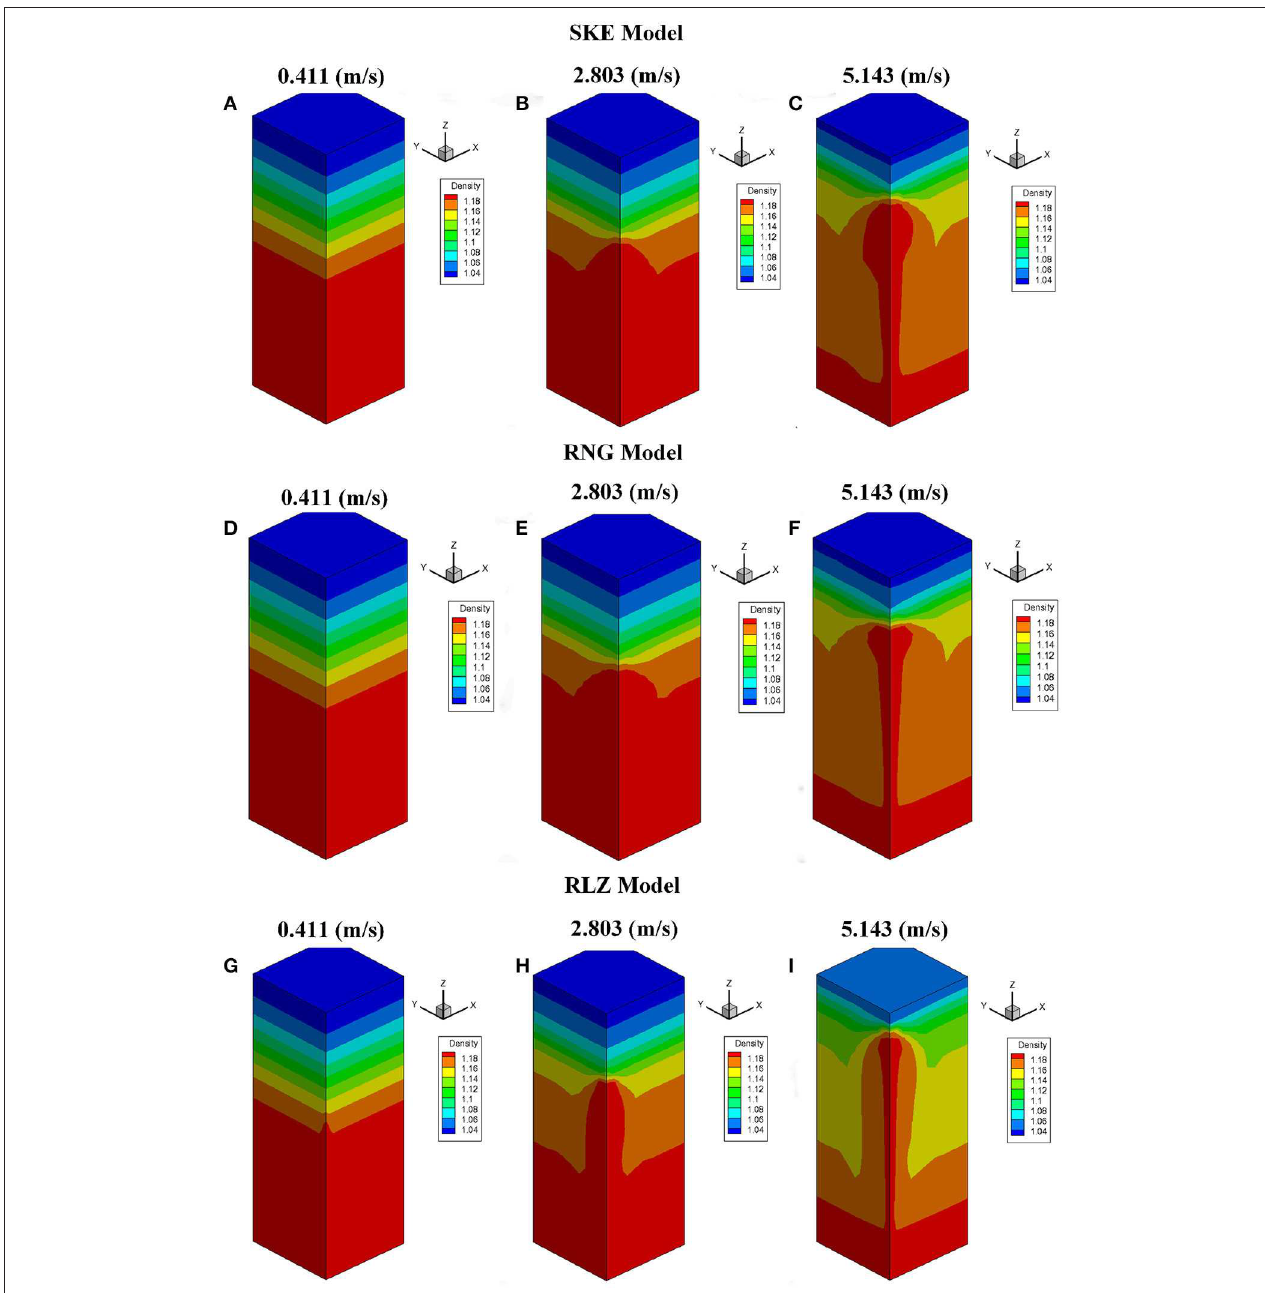
FIGURE 9 | Comparison of instantaneous mixture density (kg/m 3 ) calculated by three various air-injection velocities at 200 (s) for SKE (A) 0.411 m/s (B) 2.803 m/s (C) 5.143 m/s, RNG (D) 0.411 m/s (E) 2.803 m/s (F) 5.143 m/s, and RLZ (G) 0.411 m/s (H) 2.803 m/s (I) 5.143 m/s.